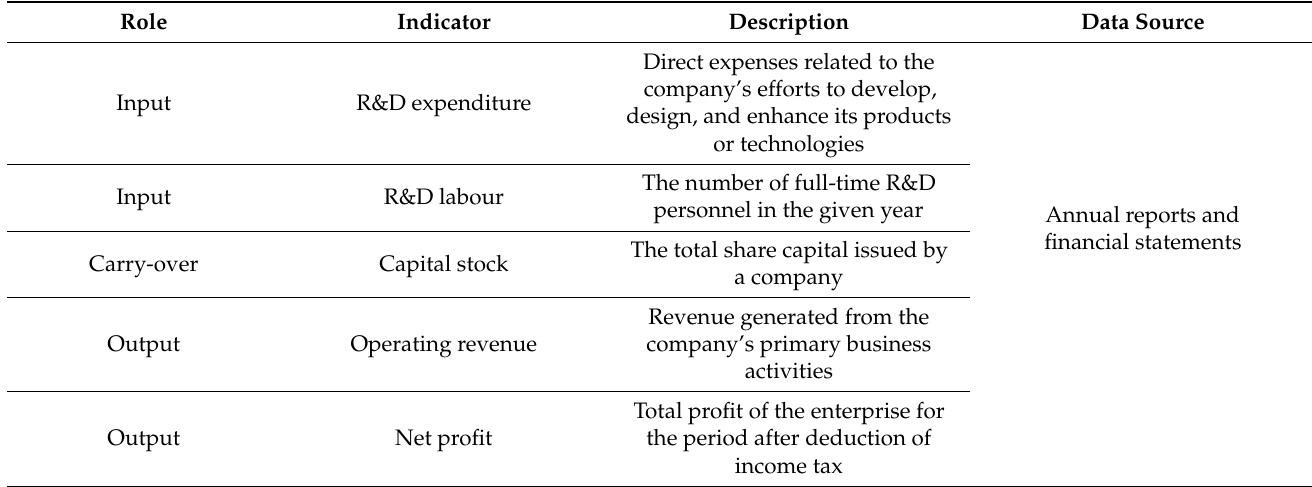
Table 4. Measure indicators of the R&D